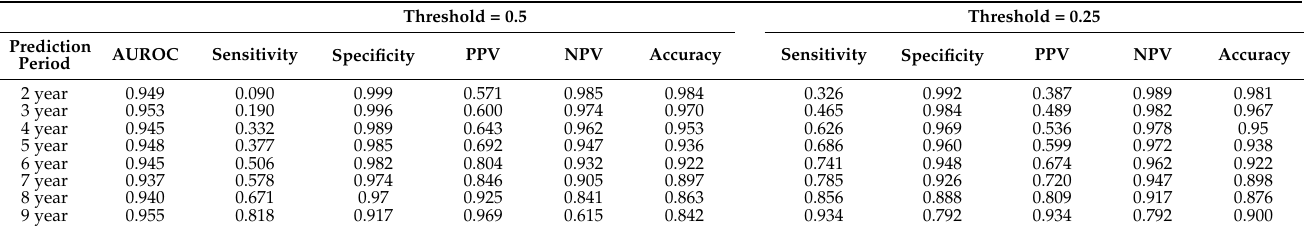
Table 3. Diabetes risk prediction model performance evaluation parameters by XGBoost Survival Embedding method. Threshold = 0.5 Threshold =